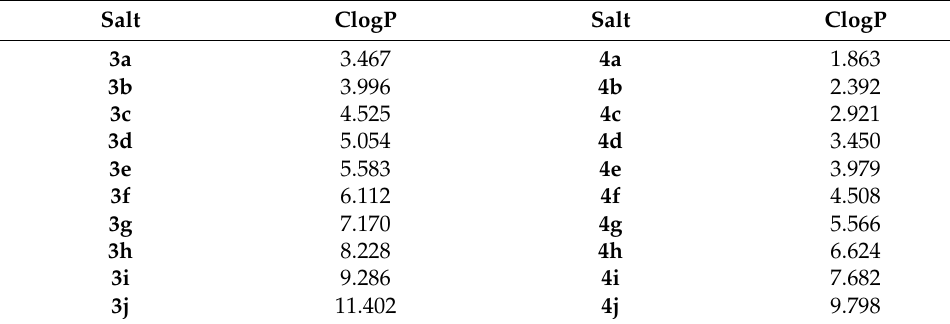
Table 4. The calculated logP (ClogP) values of imidazolium